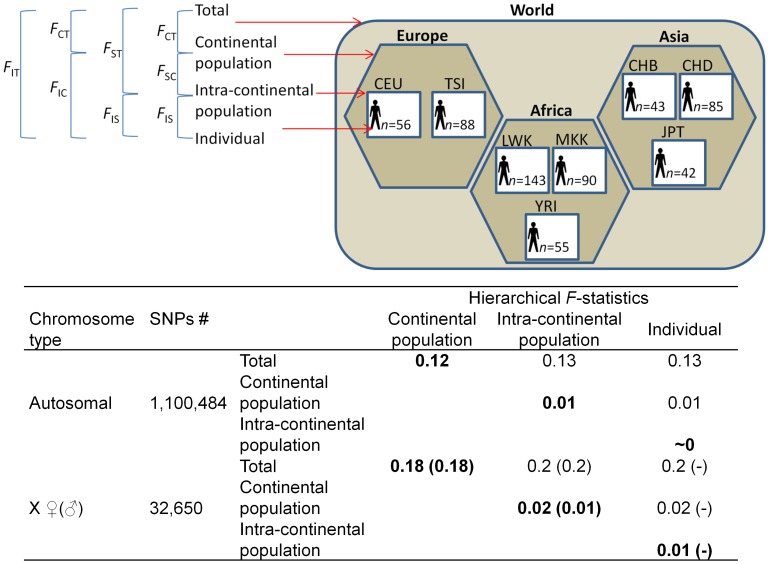
An illustration of a hierarchical F-statistics analysis using eight populations.Samples are organized in a three level structure of individuals, intra-continental populations, and continental populations. The relationships between the six fixation indices are depicted on the top left and follow the formulation of Eq. S1. For example, . Below are the F-statistics, calculated separately for autosomes, male X-chromosomes, and females X-chromosomes. The indices measuring the genetic variation between continental populations (F
CT), between intra-continental populations (F
SC), and between individuals of intra-continental populations (F
IS) are shown in bold.